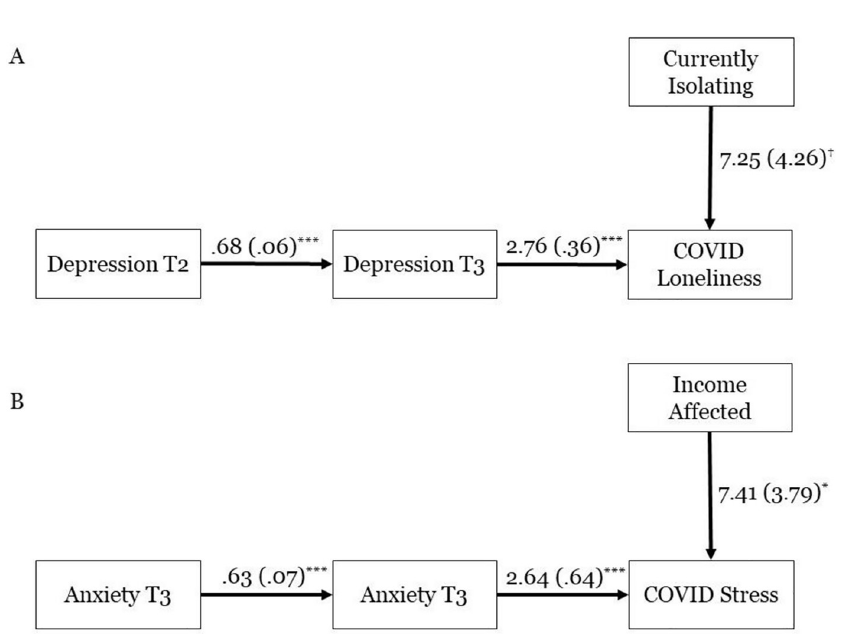
Fig 4. a and b. Structural equation model where COVID-19 depression/anxiety predicts COVID-19 loneliness/stress. ��� p < .001, � p � .05, † p < .10. T2 –Data collection at Time 2, April 15–22, 2019. T3 –Data collection at Time 3, April 15–20, 2020. The above models were excellent fits for the data (e.g., CFI = 1.00) and were therefore retained.